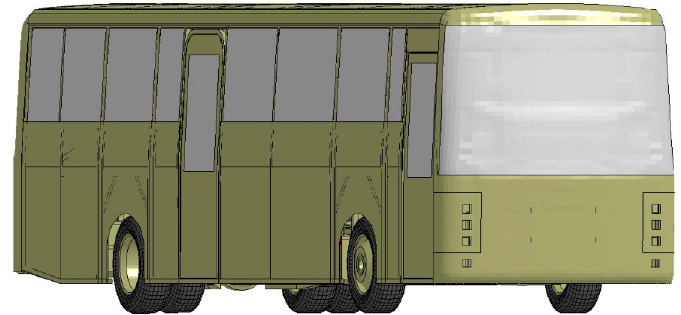
Figure 8. Finite element model of the 13,000 kg bus [NCAC, 2008].